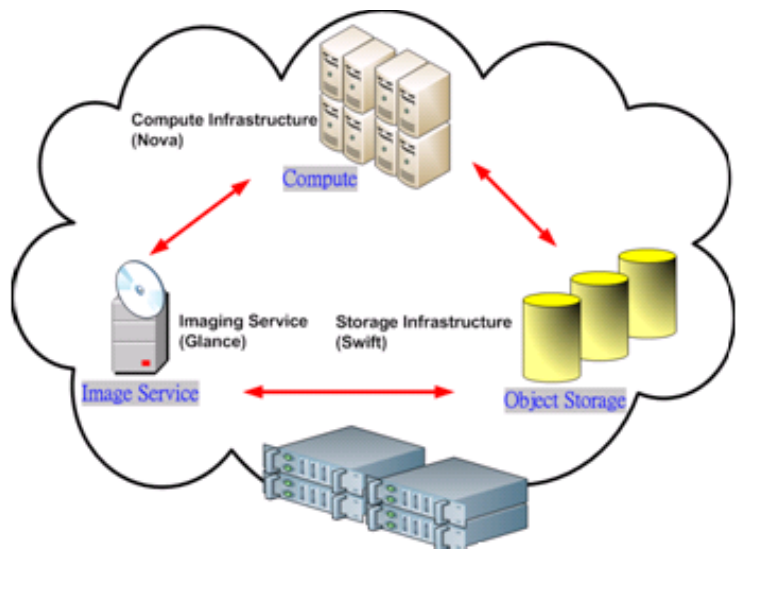
Figure 1 . Architecture of OpenStack. The Components of the